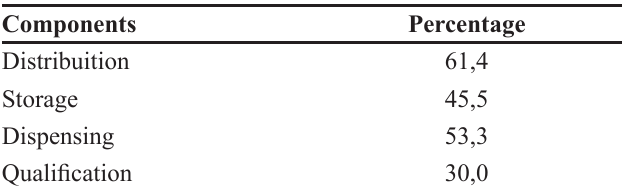
TABLE III - Overall result for the assessment for the Health Foundation of Niterói city (HFN) for pharmaceutical services